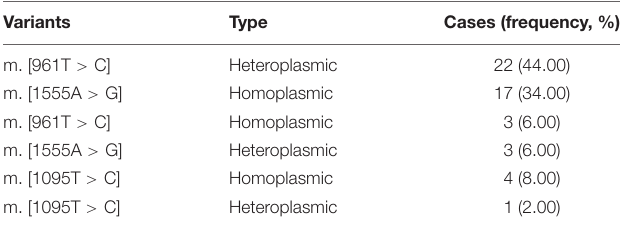
TABLE 5 | Fifty MT-RNR1 variants and genotypes.